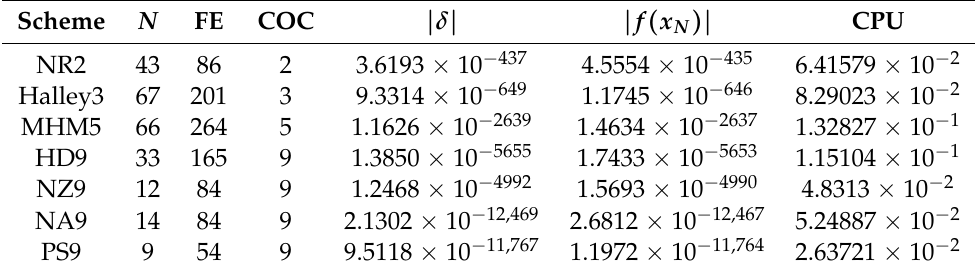
Table 10. Numerical results for the problem 5 with the initial guess V 0 = 0.0